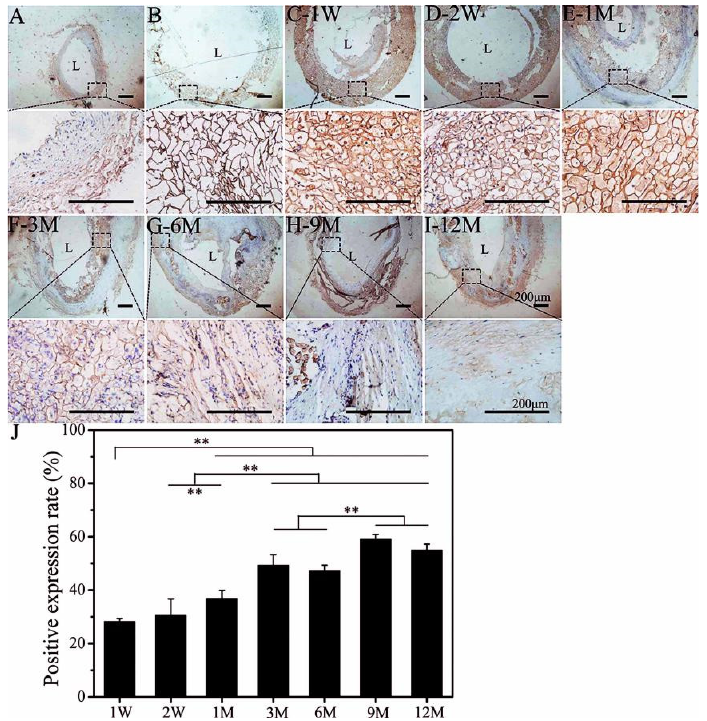
Figure 3. Immunoenzyme staining of COL-I. ( A ): Autogenous carotid artery; ( B ): non-implanted SFTS; ( C–I ): different time points after implantation of SFTSs; ( J ): semi-quantitative results of positive expression. “L” represents the lumen. The scale bar is 200 μ m. “**” represents p < 0.01. Polymers 2022 , 14 , x FOR PEER REVIEW COL-III is mainly found in the intima and adventitia of the blood vessel wall, which provides tensile strength for the blood vessel and plays a role in regulating the self-assembly of COL-I fibers [44,45]. COL-III also plays a part in cell adhesion, migra- tion, proliferation, and differentiation through its interaction with integrins [46]. A brown area was seen in the wall of SFTSs at 1 M after implantation (Figure 4E). This brown area deepened, and the distribution area increased at 3 M (Figure 4F) and became ordered along the circumferential layers at 6 M (Figure 4G), which was consistent with the depo- sition and distribution of elastin and COL-I, but the amount of deposition was relatively low. The synthesis of COL-III increased significantly and showed a dark brown positive expression at 12 M (Figure 4I). Semi-quantitative results show that the deposited quantity of COL-III in the SFTS gradually increased, reaching a stable state at 9 M (Figure 4J).